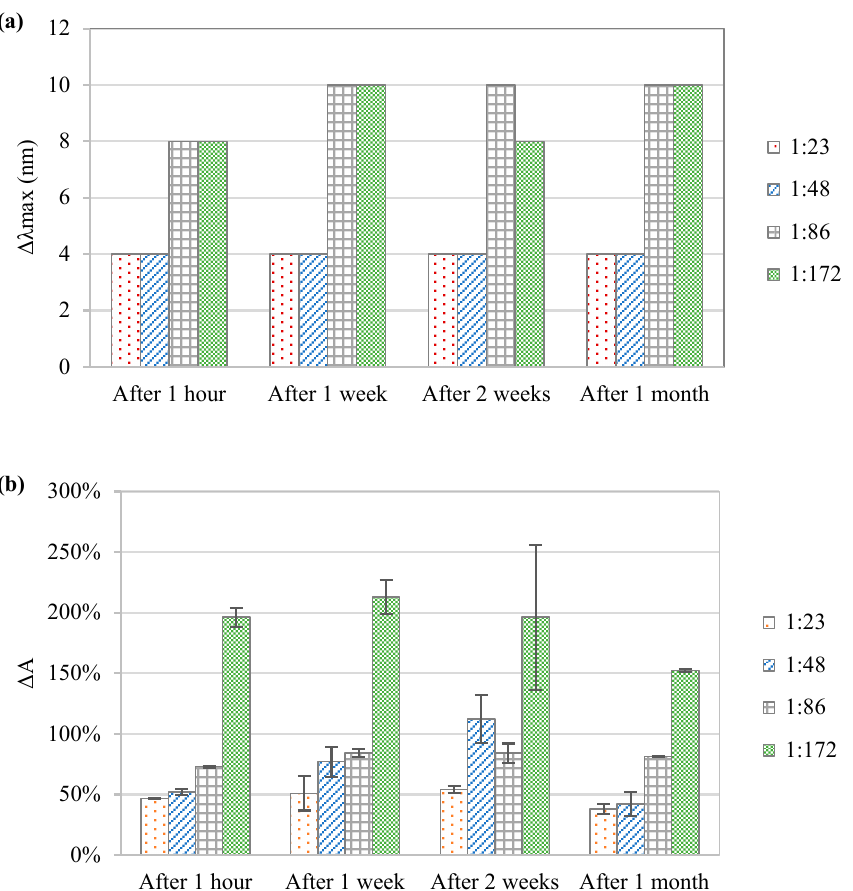
Figure 3. Effect of the anthocyanin: co-pigment ratio on the preservation of chokeberry extracts during 1 month storage at 5 °C: ( a ) absorption maximum shift ( Δ λ max ) and ( b ) increase of absorbance intensity ( Δ A %).